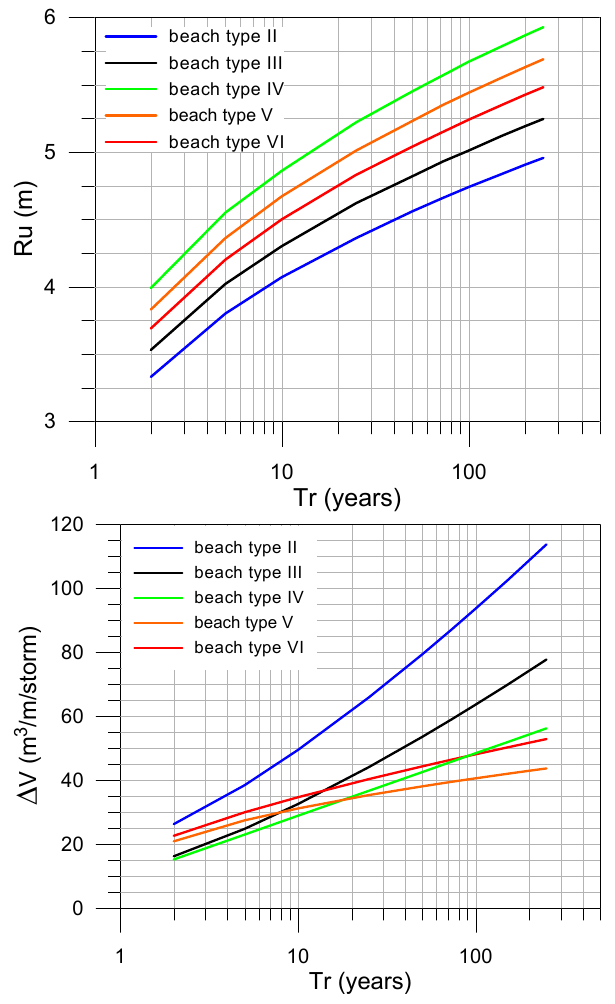
Fig. 7. Extreme probability distributions obtained for inundation and erosion hazards and for different beach